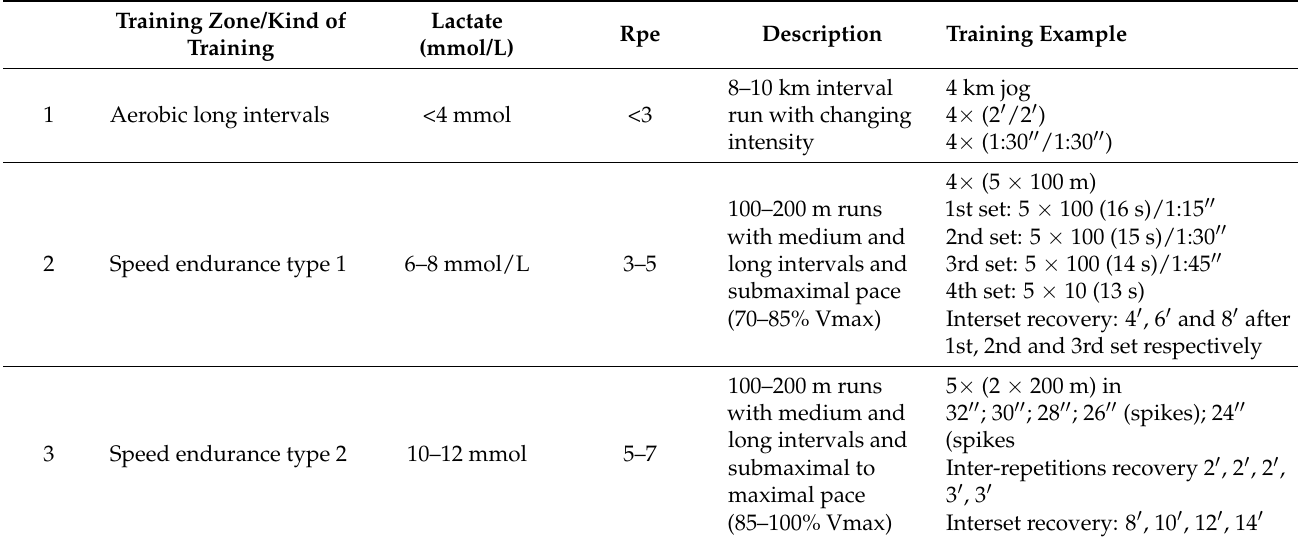
Table 3. 400 m training